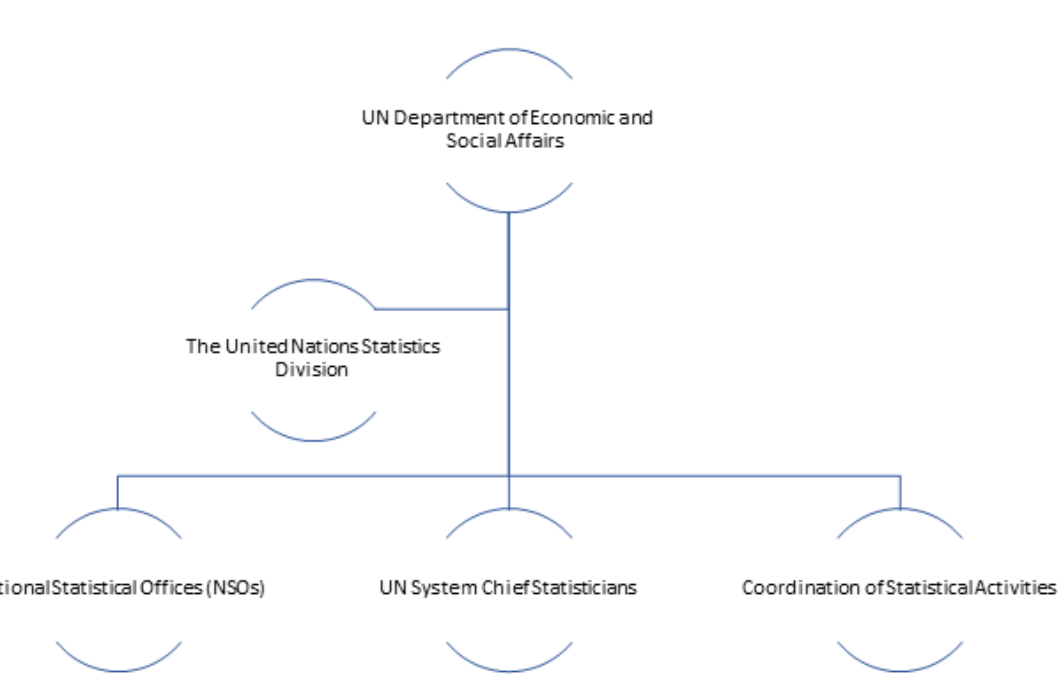
Figure 1. Organizational structure of the international official statistics